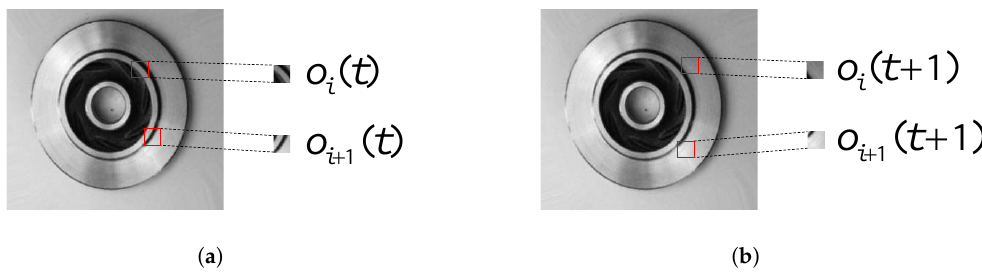
Figure 3. Schematic diagram of local observations. ( a ) The local observations of the i-th agent and the i + 1-th agent at time t ; ( b ) The local observations of the i-th agent and the i + 1-th agent at time t +